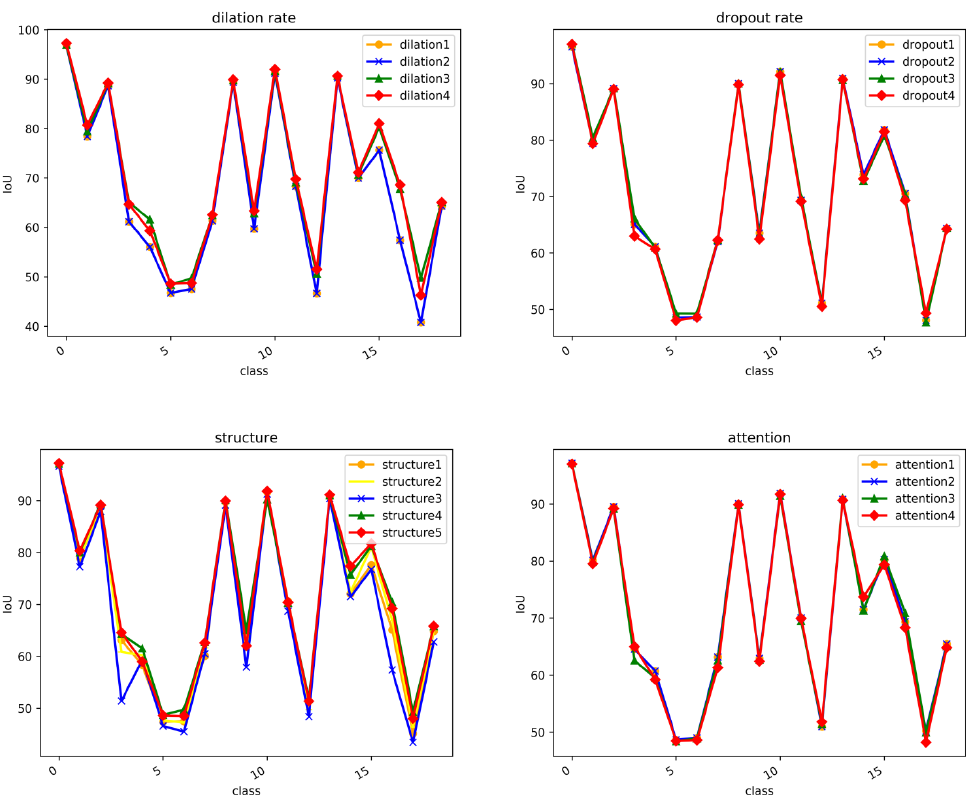
Figure 7. Qualitative results of Ablation